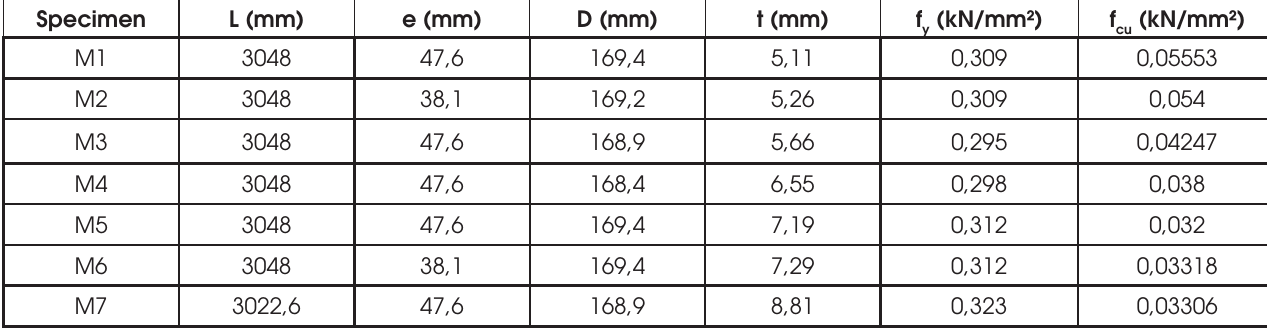
Geometry and material